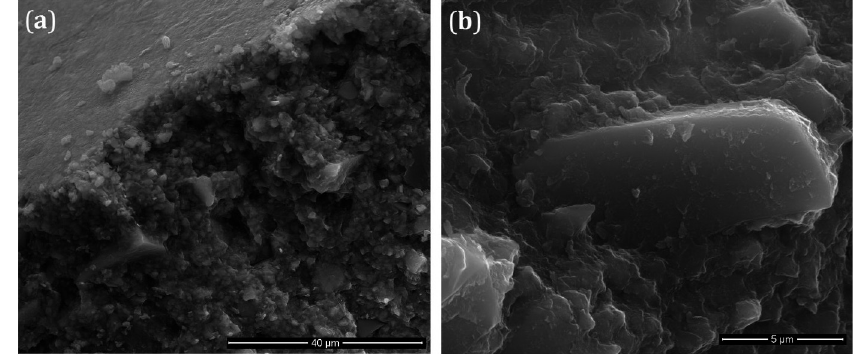
Figure 5- Scanning electron microscopy (SEM) micrographs of G-DU taken at 3,000× (a) and 15,000× (b)